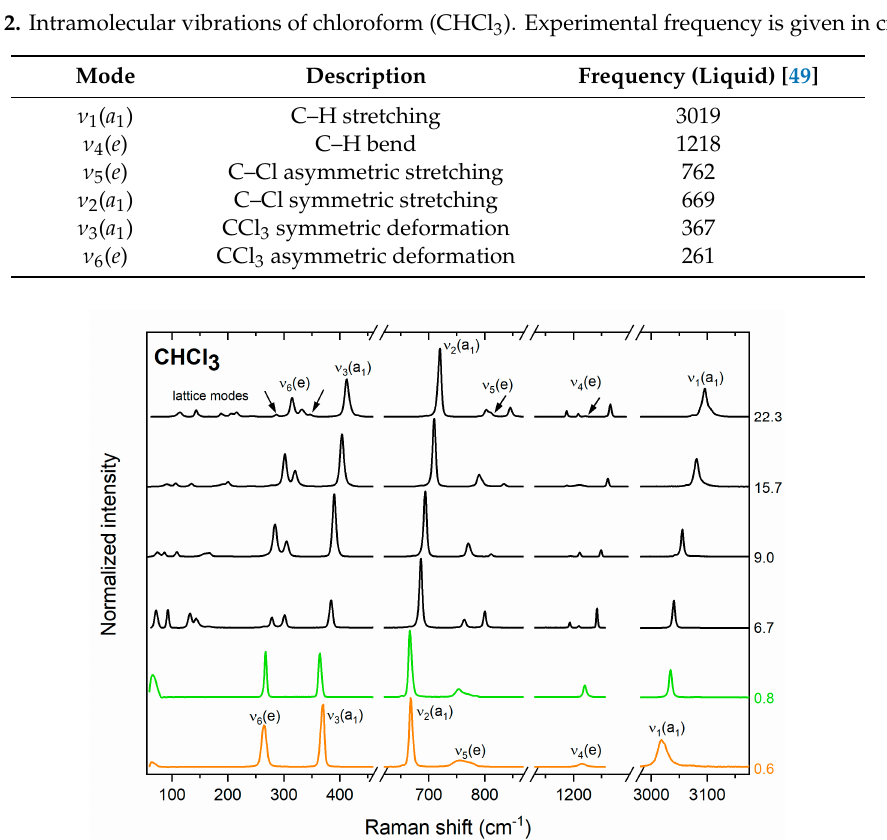
Figure 1. Experimental Raman spectrum of liquid (orange line) and polycrystalline (green and black lines) CHCl 3 at selected pressure (given in GPa). Green lines denote spectra obtained from the disordered P6 3 structure and black lines denote spectra of the Pnma phase. Arrows indicate new bands appearing upon compression of the Pnma structure.